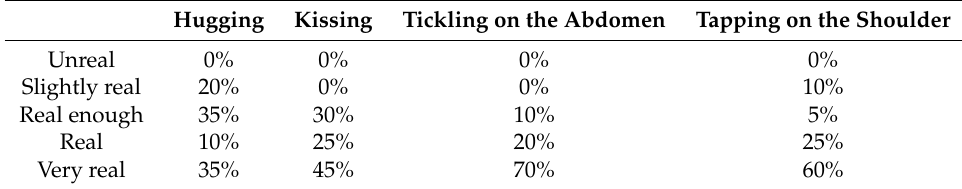
Table 1. Results of the Fidelity of Affection Gestures questionnaire.